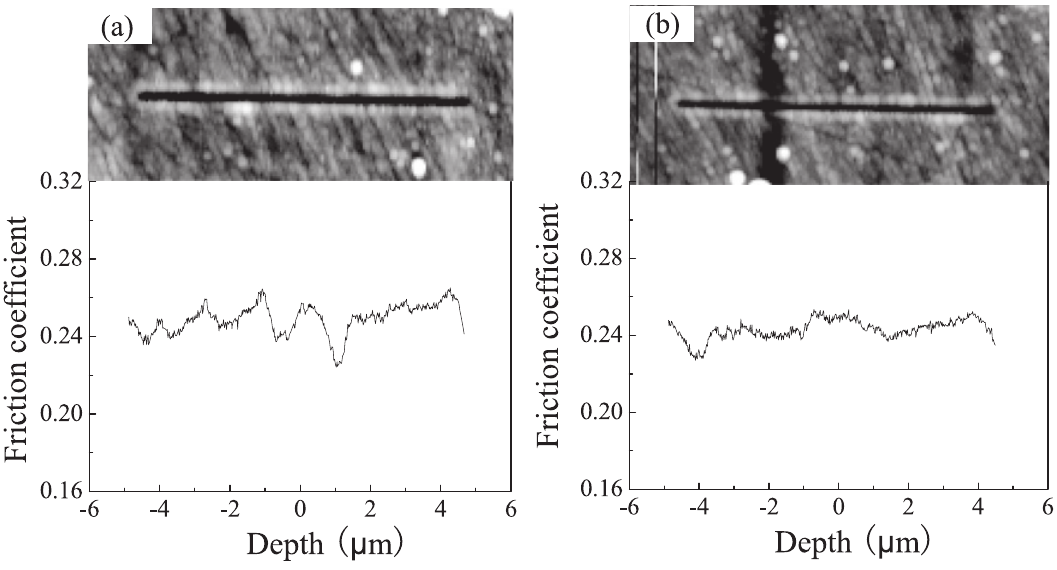
Fig. 7: Micrograph of scratches and friction coefficient of the CuZn alloy. (a) Original; (b) after 3 GPa